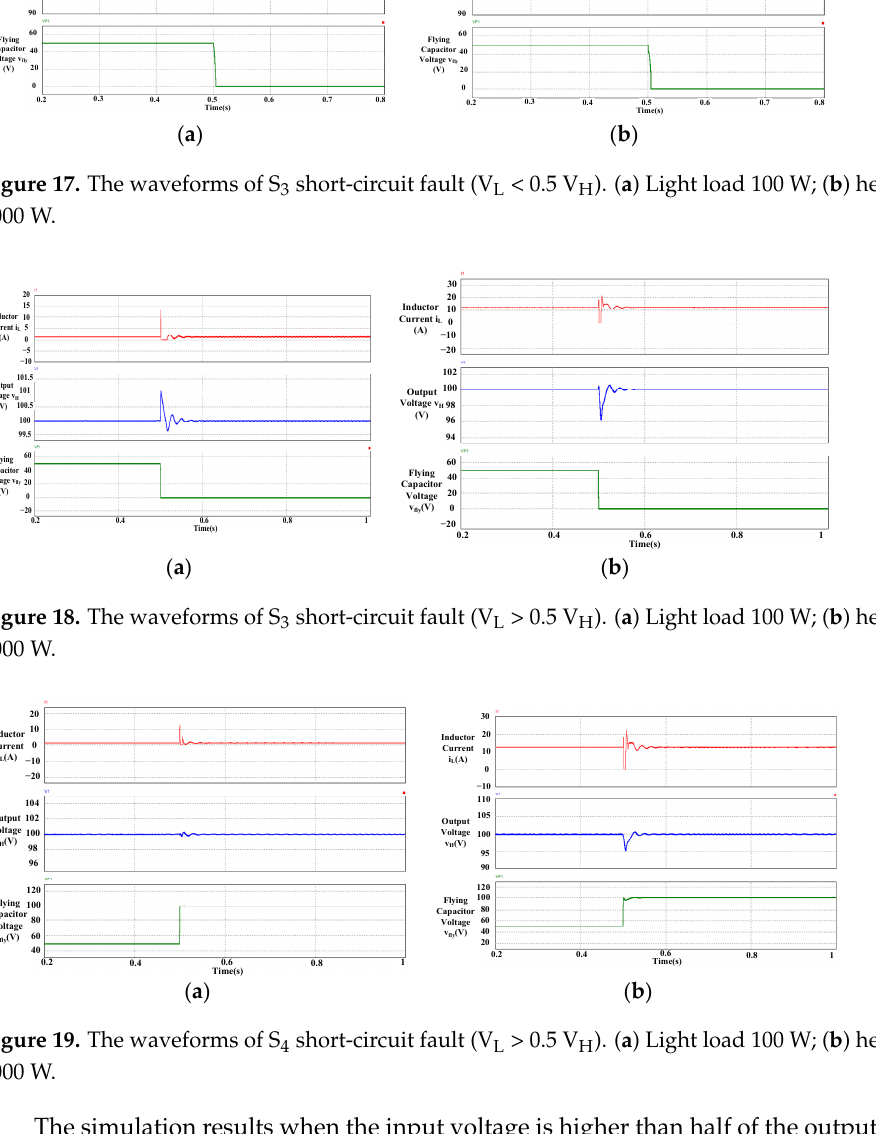
Figure 19. The waveforms of S 4 short-circuit fault (V L > 0.5 V H ). ( a ) Light load 100 W; ( b ) heavy load 1000 W. 1000